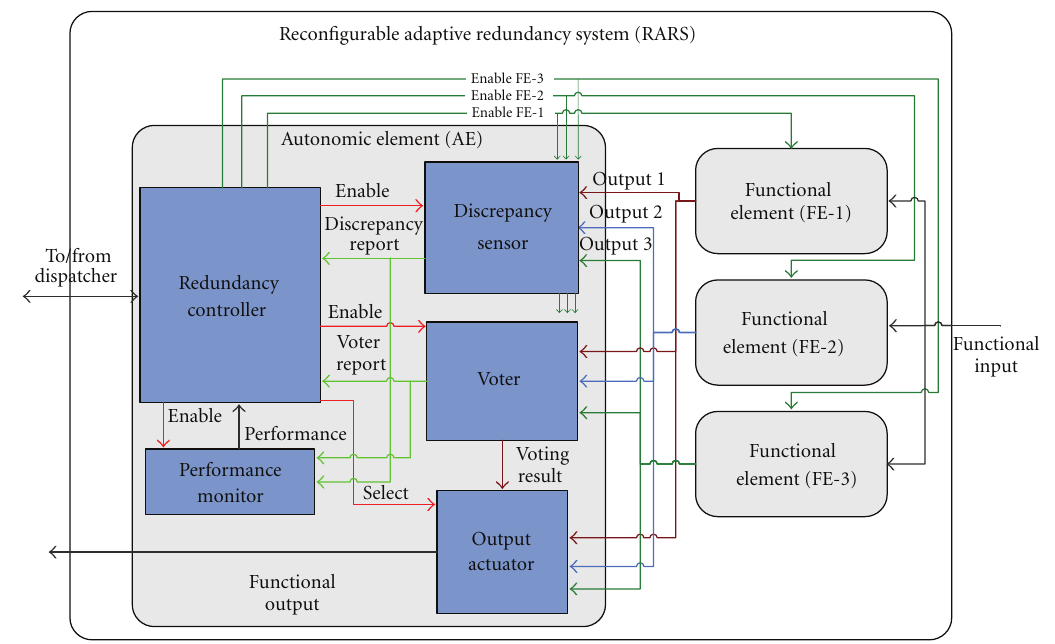
Figure 3: Reconfigurable adaptive redundancy system (RARS).